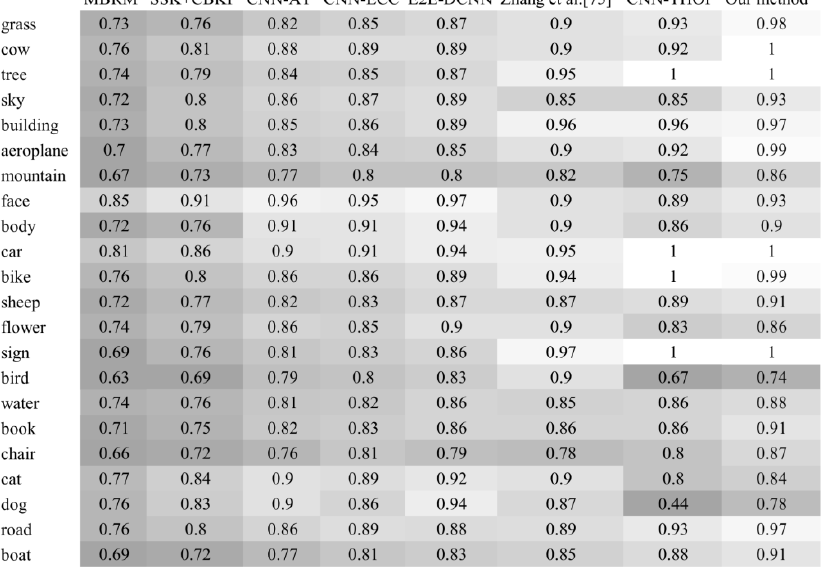
Figure 9. Precision heatmap generated from the precision per concept produced by each method. Lower precisions are indicated by darker cells. The methods involved in this experiment are MBRM [27], SSK-CBKP [89], CNN-AT [54], CNN-ECC [90], E2E-DCNN (2019) [66], CNN-THOP [74], Zhang et al. [76], and our method.